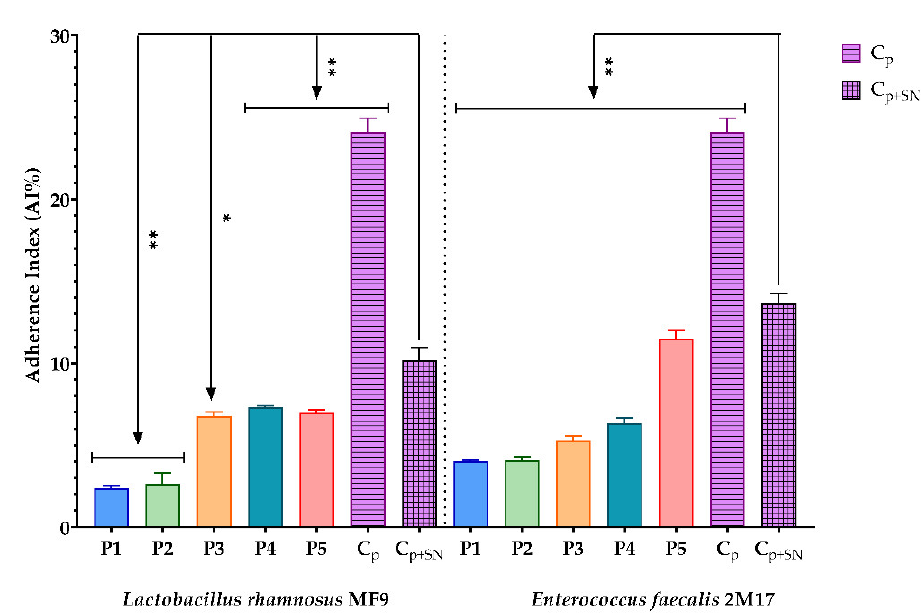
Figure 8. Graphic representation of AI% values representing the synergic influence of BPE and probiotic Soluble Compounds (SN) on the adherence capacity of Candida guillermondii; (P1–P5)-BPE samples, pathogenic strains adherence control (Cp), pathogenic strains with probiotic supernatant adherence control (C P+SN ). The differences between the effects of BPE and soluble compounds of strains on the adherence capacity of clinical yeast strains were statistically analysed using one-way ANOVA. Furthermore, Dunnett’s test for multiple comparisons of groups was performed. The results were considered statistically significant. (ns p > 0.05; * p < 0.05; ** p < 0.009).